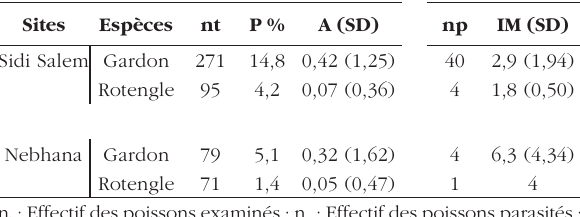
Tableau I. – Effectifs des poissons examinés, parasités, et paramètres épidémiologiques de la Ligulose chez le gardon et le rotengle dans les retenues de barrages de Sidi Salem et de